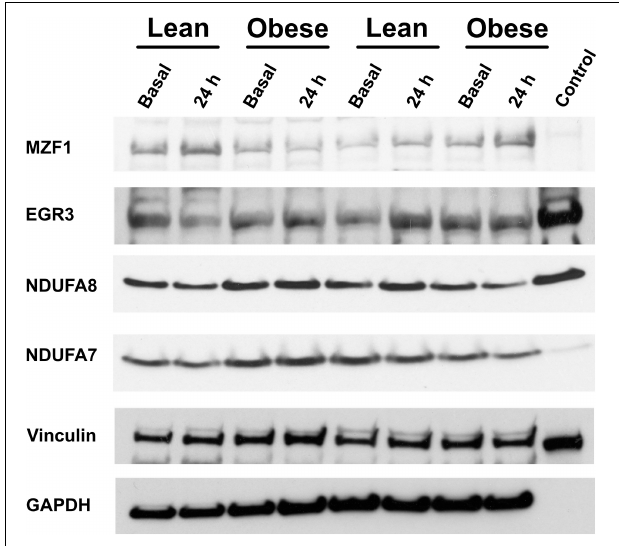
FIGURE 5 | Representative immunoblots of proteins for which data is given in Figure 4